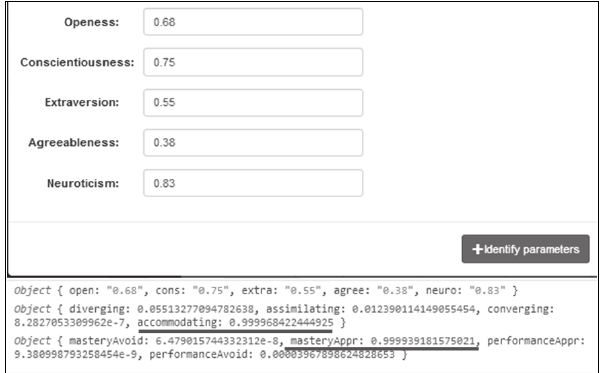
Fig. 5. Identification of learning style and achievement